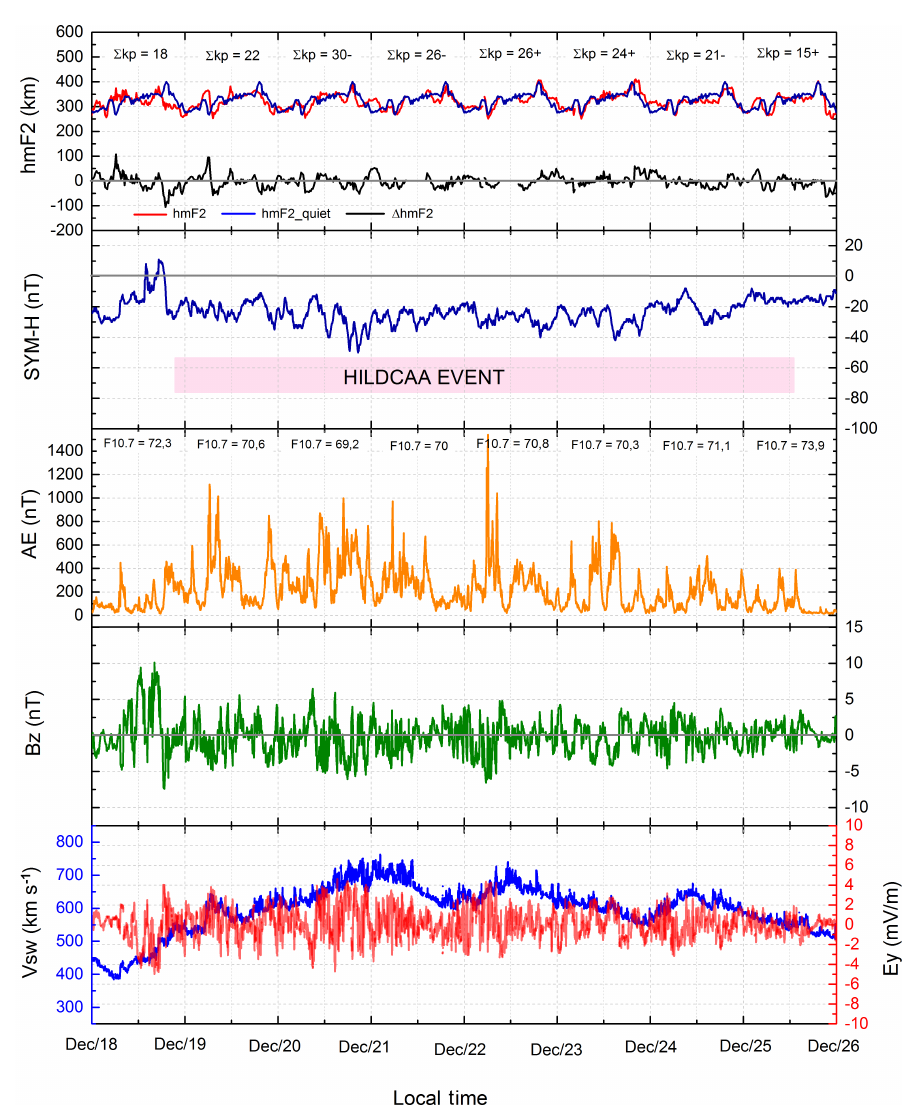
Figure 3. Same as Fig. 1 but for the HILDCAA event that occurred during 18–26 December 2006